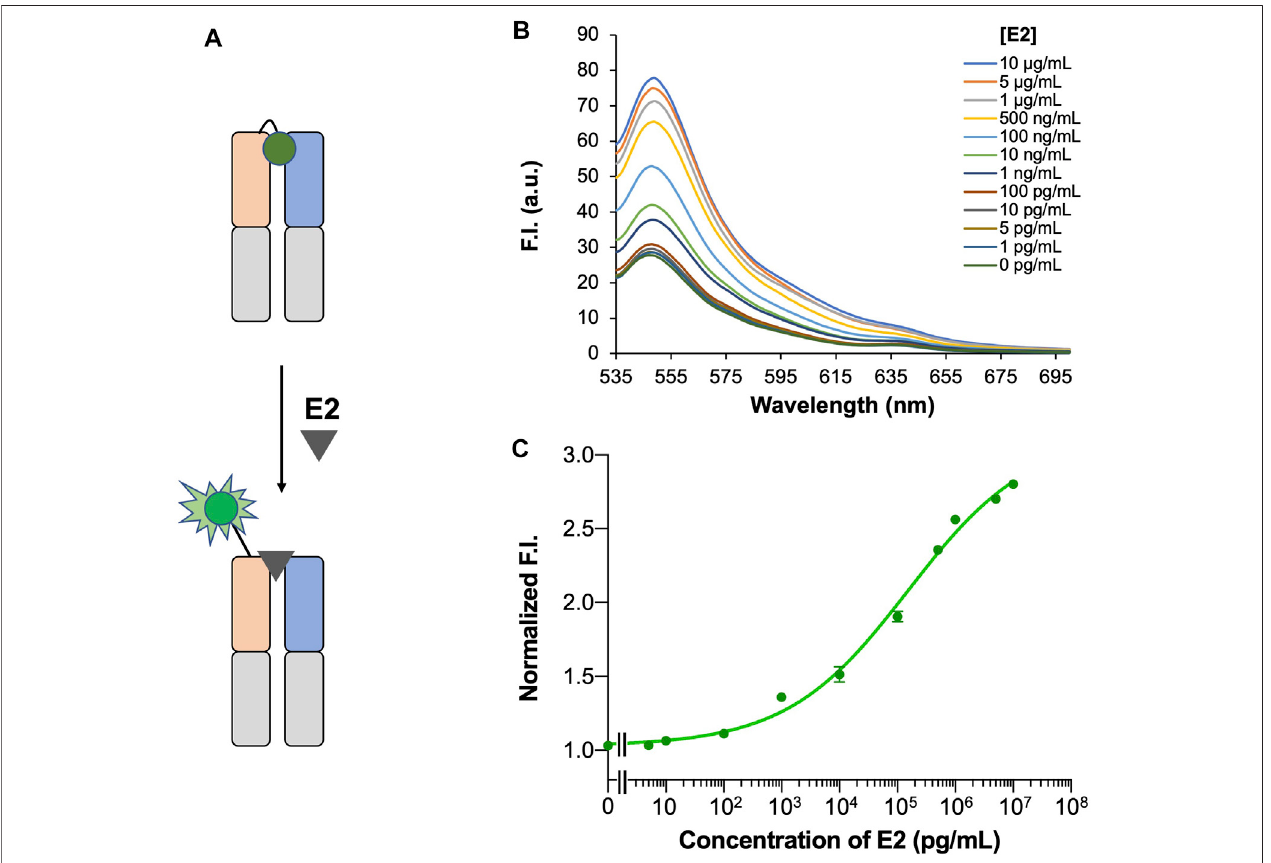
FIGURE 5 | Detection of E2 with ESC9 Q-body. (A) Scheme for E2 detection with the ESC9 Q-body; (B) Fluorescent spectrum of the ESC9 Q-body for E2 detection; (C) Concentration-dependent relationship curve for the detection of E2 with ESC9 Q-body.